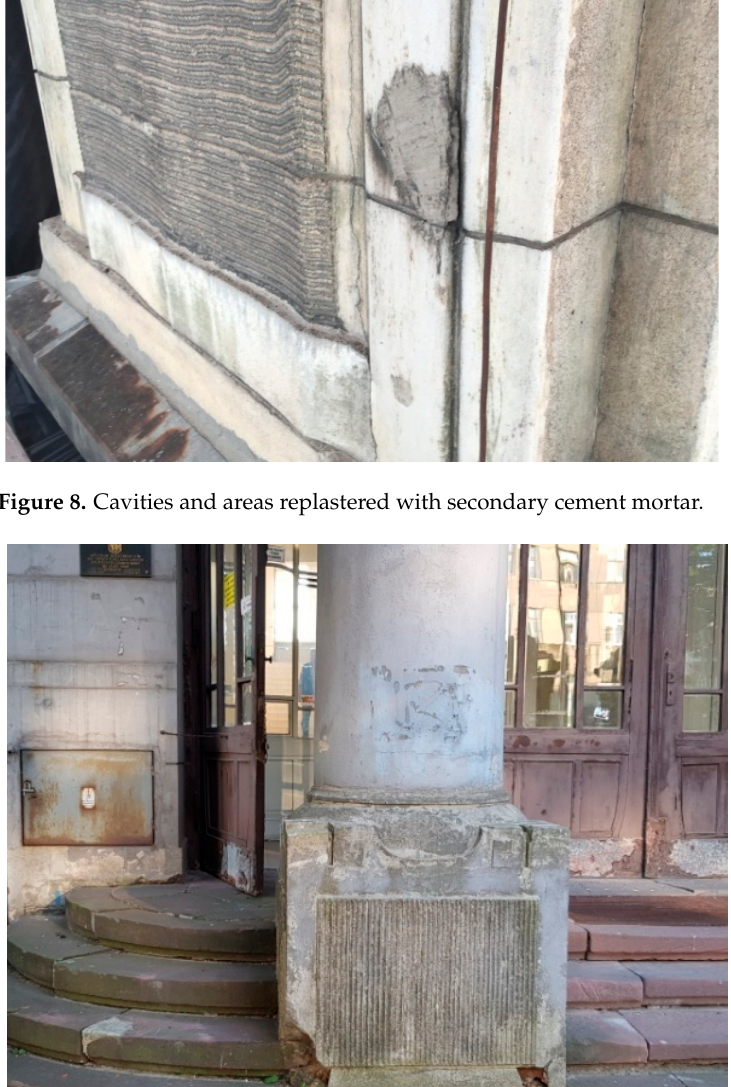
Figure 7. Damage to the layer around the reinforcement—visible rebars.